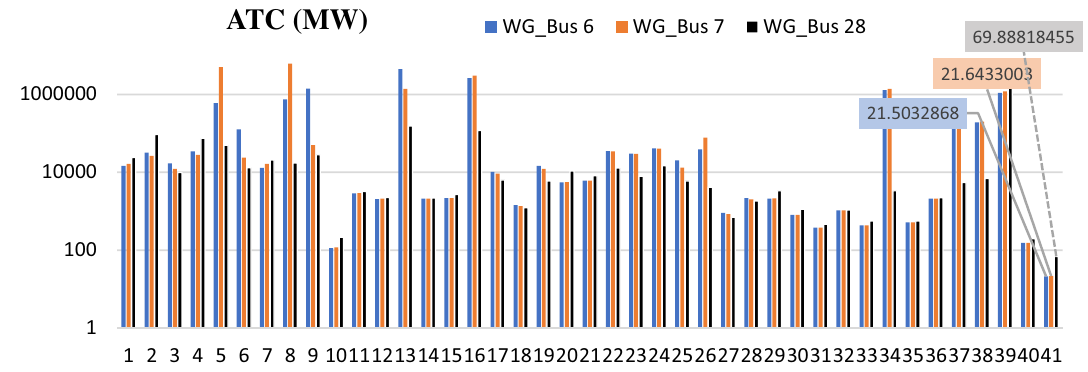
Fig. 3 ATC Comparison in limiting line between bus 6–28 due to optimally placed WG in Zone 1